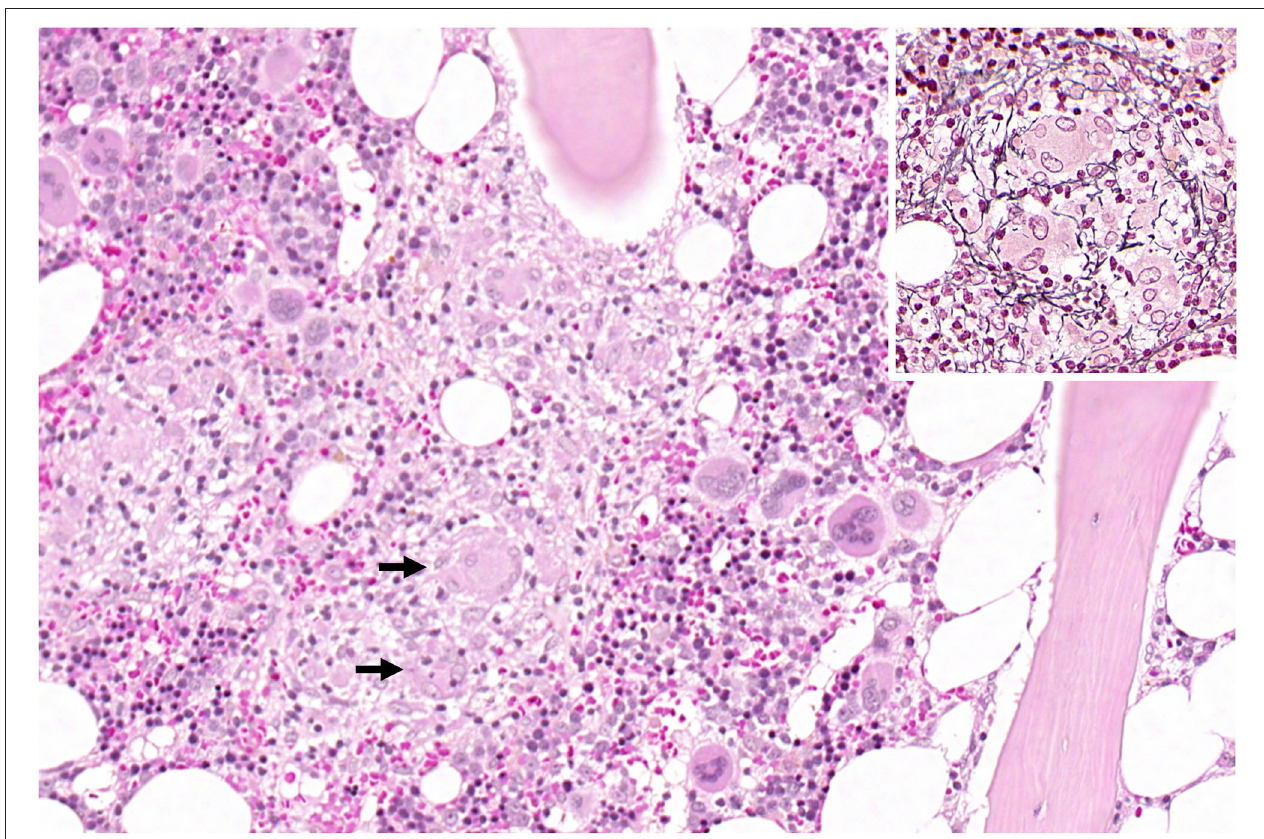
FIGURE 2 | Overview of haematopoietic bone marrow with a central granuloma. The arrows mark multinucleated giant cells. The inset shows a granuloma with the typical radially arranged fibres in the reticulin fibre